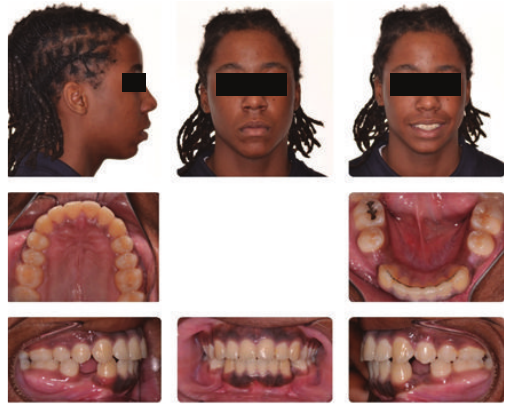
Figure 14: Stage 2: Orthodontic Treatment Initial